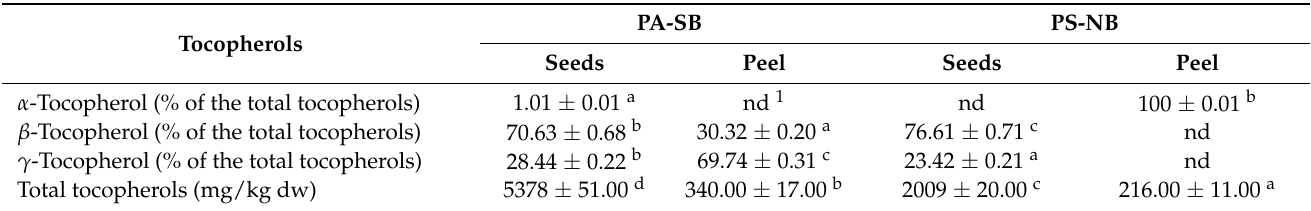
Table 4. Tocopherol composition of seed and peel oils of two P. alkekengi phenotypes (PA-SB and